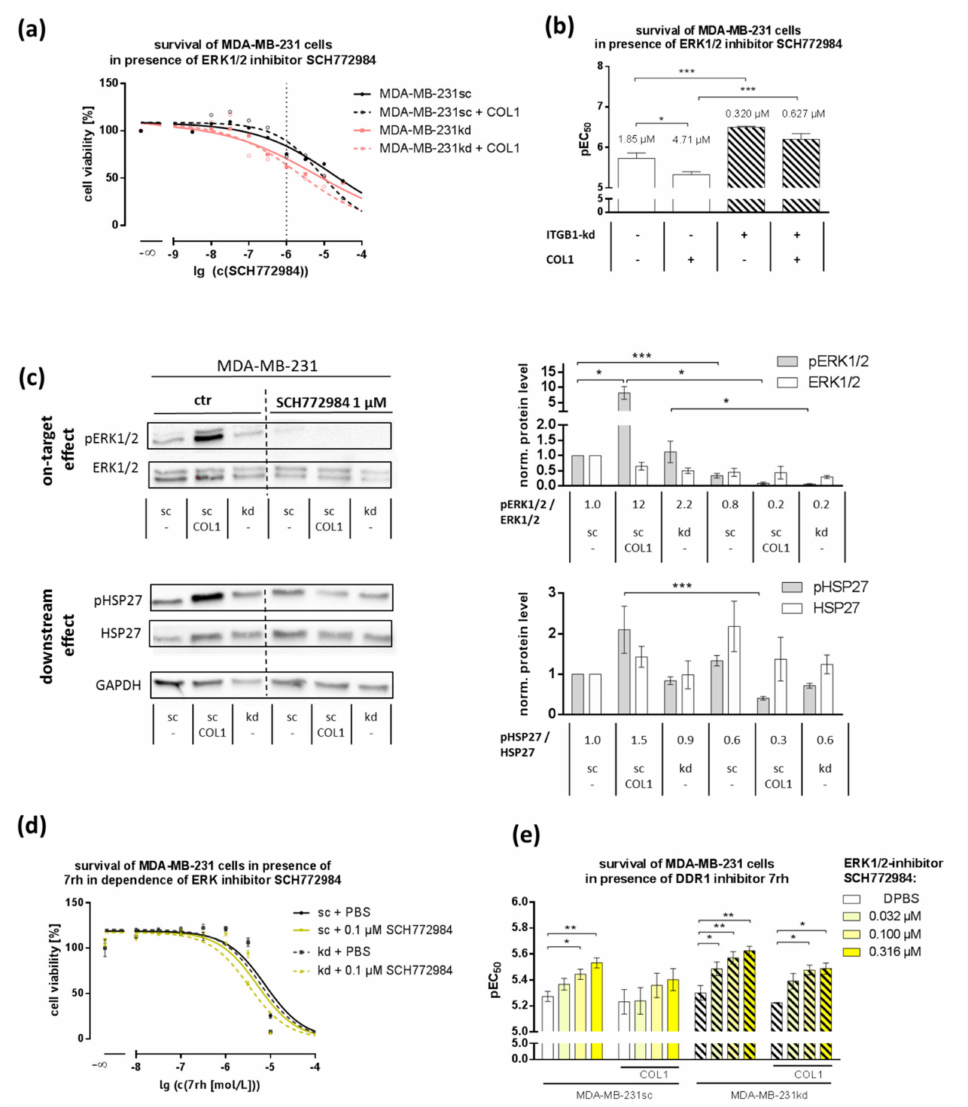
Figure 4. ( a ) Representative survival curves of MDA-MB-231 cells in the presence of ERK1 / 2-inhibitor SCH772984 for 72 h revealed a higher sensitivity of the integrin β 1 -knockdown (ITGB1-kd) cells towards ERK1 / 2-inhibition compared to scrambled (sc) cells and a higher resistance upon collagen type 1 (COL1) binding, indicated by the statistical analysis on these cytotoxicity data shown in ( b ) ( n = at least 5 biological samples). ( c ) Western blot analysis of pERK / ERK and pHSP27 / HSP27 with GAPDH as loading control after incubation with ERK1 / 2–inhibitor SCH772984 in MDA-MB-231 cells ( n = at least 3 biological samples). ( d , e ) Combination e ff ect of 7rh and SCH772984 cytotoxicity in MDA-MB-231 cells shows the pEC 50 values of Discoidin Domain Receptor 1 (DDR1) inhibitor 7rh cytotoxicity in the dependence of SCH772984 ( n = at least 3 biological samples). MDA-MB-231 cells display a significant increase in pEC 50 . Statistical analysis was performed via unpaired t -test (* p < 0.05; ** p < 0.01; *** p <